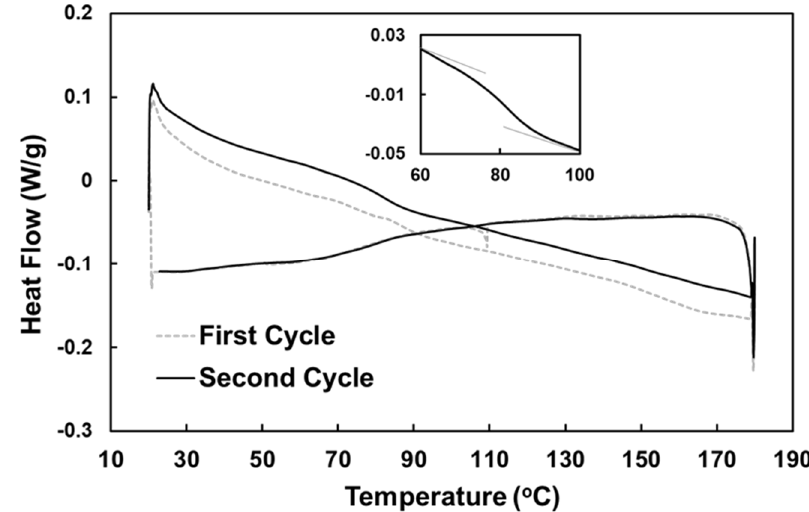
Figure 2. DSC results of the PVC foam. Inset: zoom-in view of the glass transition range during heating.